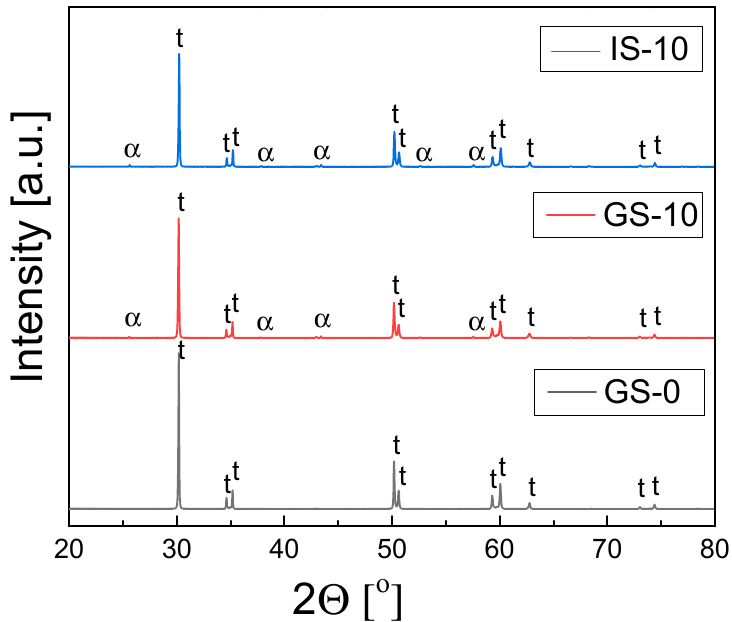
Figure 3. Diffraction patterns recorded for GS-0, GS-10 and IS-10 samples obtained via 2 h of sintering in air at 1773 K.